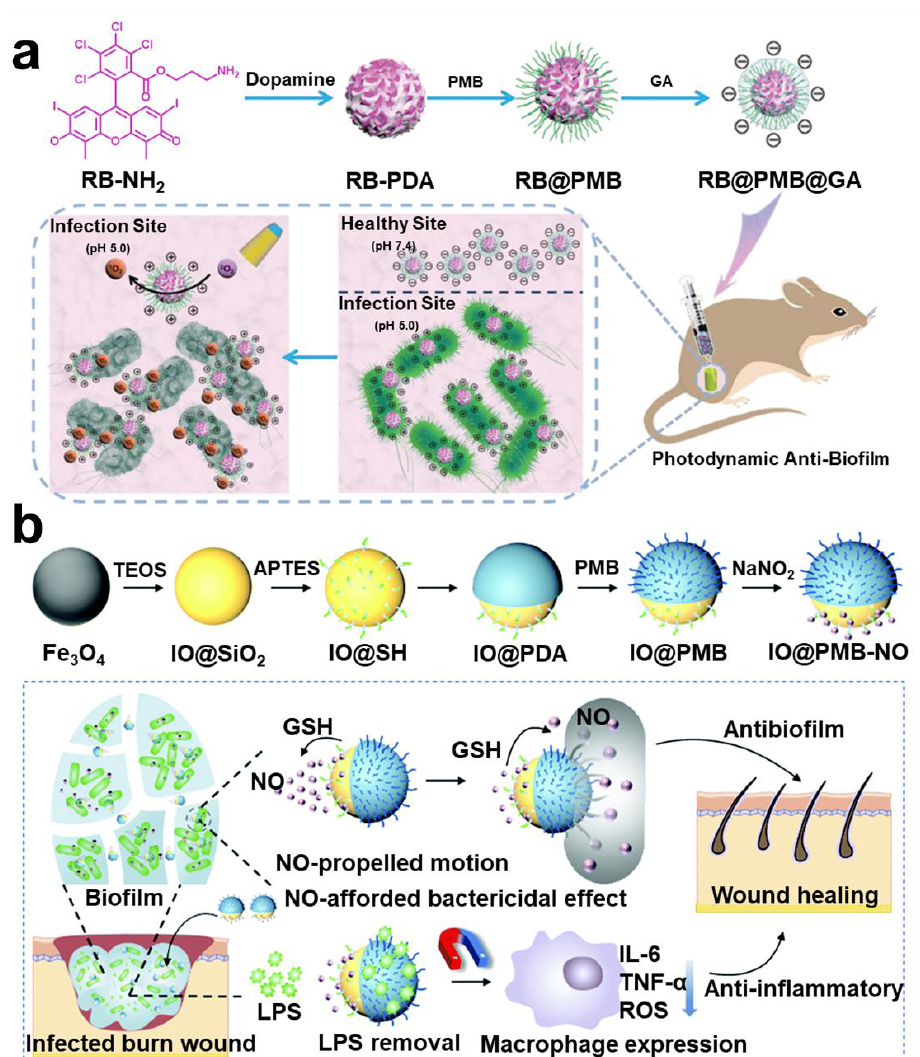
Figure 11. Using negative overexpression GSH and H 2 O 2 to realize intelligent response technol- ogy. ( a ) Nanoparticles with charge reversal; the retention capacity of nanoparticles is improved through electrostatic interaction, thereby improving the antibacterial effect. Reprinted with permis- sion from Ref. [206]. Copyright 2021, Fu-Jian Xu. ( b ) A therapeutic regimen that utilizes NO to deplete GSH and trigger immunotherapy. Reprinted with permission from Ref. [210]. Copyright 2022, Xiaohong